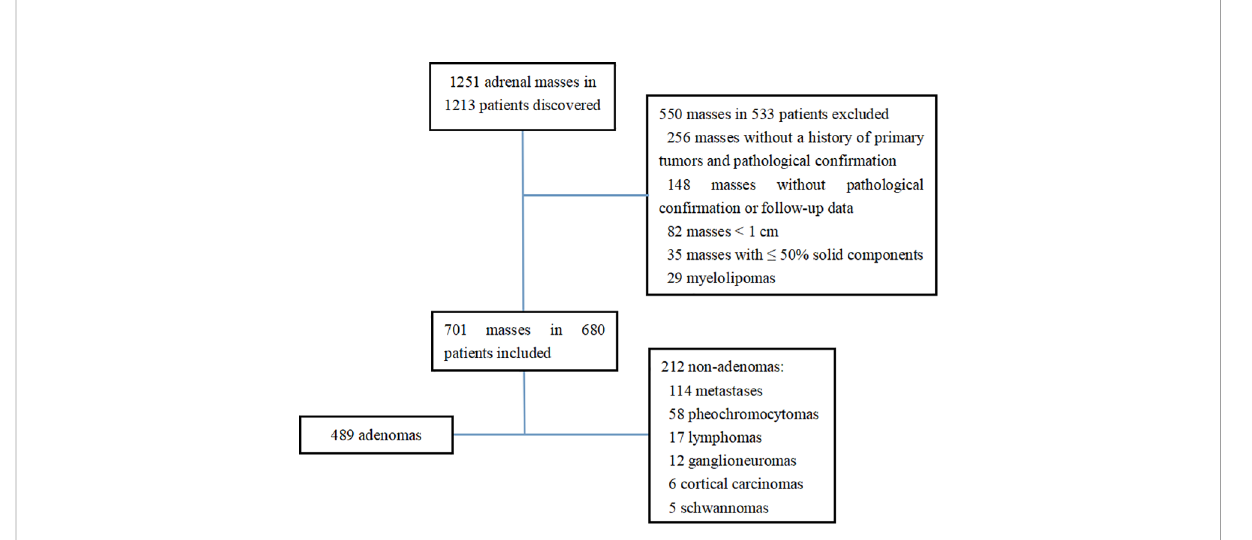
FIGURE 1 Flowchart of study